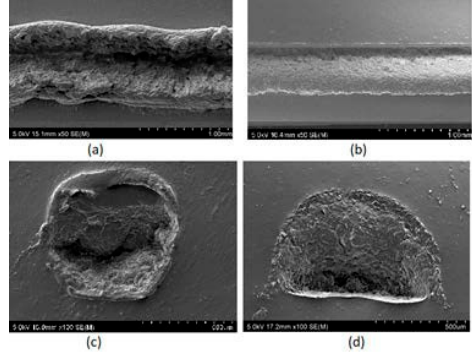
Figure 3. SEM micrograph of the CB nanocomposite in sensor fabricated ( a ) lengthwise cross section of “embedded” printing and ( b ) lengthwise cross section of “layer-upon-layer” printing ( c ) widthwise cross section of “embedded” printing and ( d ) widthwise cross section of “layer-upon-layer”